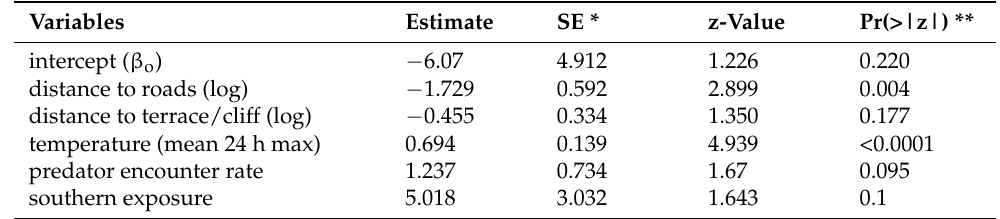
Table 7. Model averaged estimates and significance of the fixed effect variables predicting mouflon visitation rate at the weekly time scale, as measured in the number of independent mouflon detection events at ten monitored water troughs (R 2 = 0.979; negative binomial generalized mixed-effect model with site (water trough) and week as nested random effects (fixed slope, random intercept)).